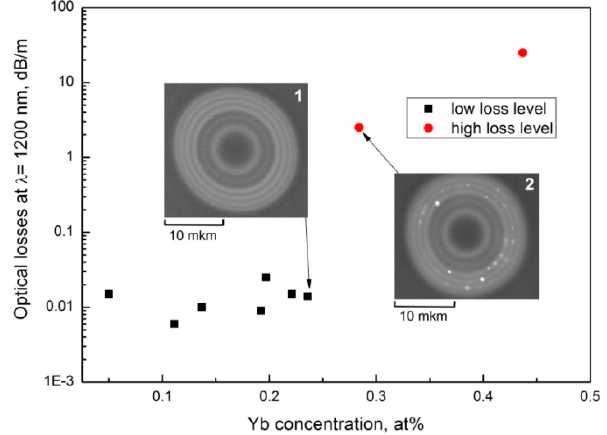
Figure 6. The dependence of optical losses in fabricated fibers on the concentration of Yb in an Er–Yb–FPS glass core. Inserts: the photograph of a fiber core doped with 0.24 at% Yb (1) and 0.29 at% Yb (2).